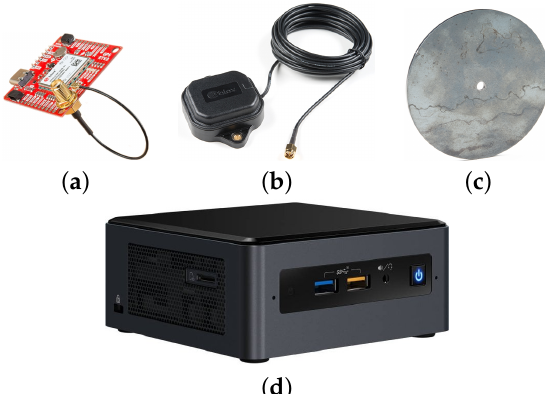
Figure 5. Hardware components of the sensor system: a GNSS-RTK board ( a ), an antenna ( b ), a ground plate ( c ) and the mini computer ( d ).